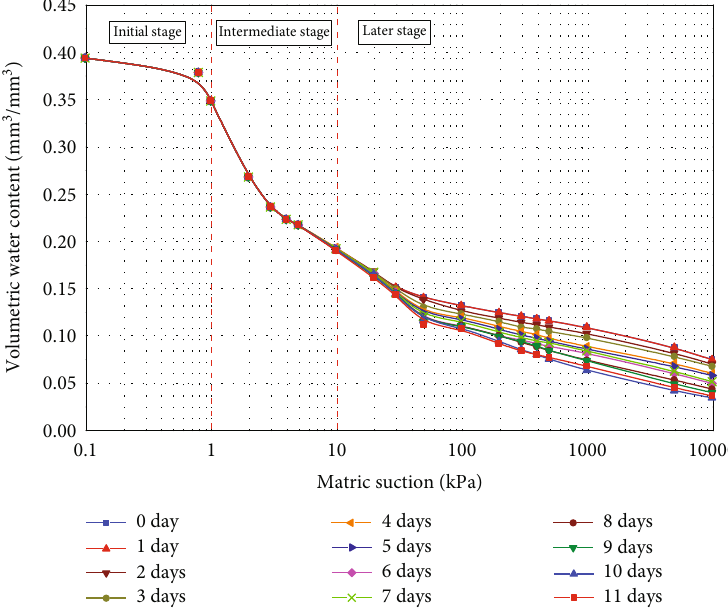
Figure 11: Soil water characteristic curves of soil samples after di ff erent days of